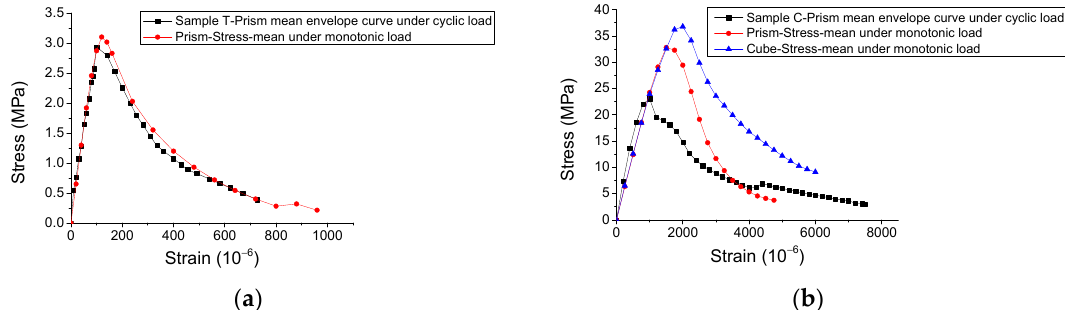
Figure 10. Comparison between envelope and monotonic stress-strain curves for SCC. ( a ) Direct tensile case and ( b ) compressive case.